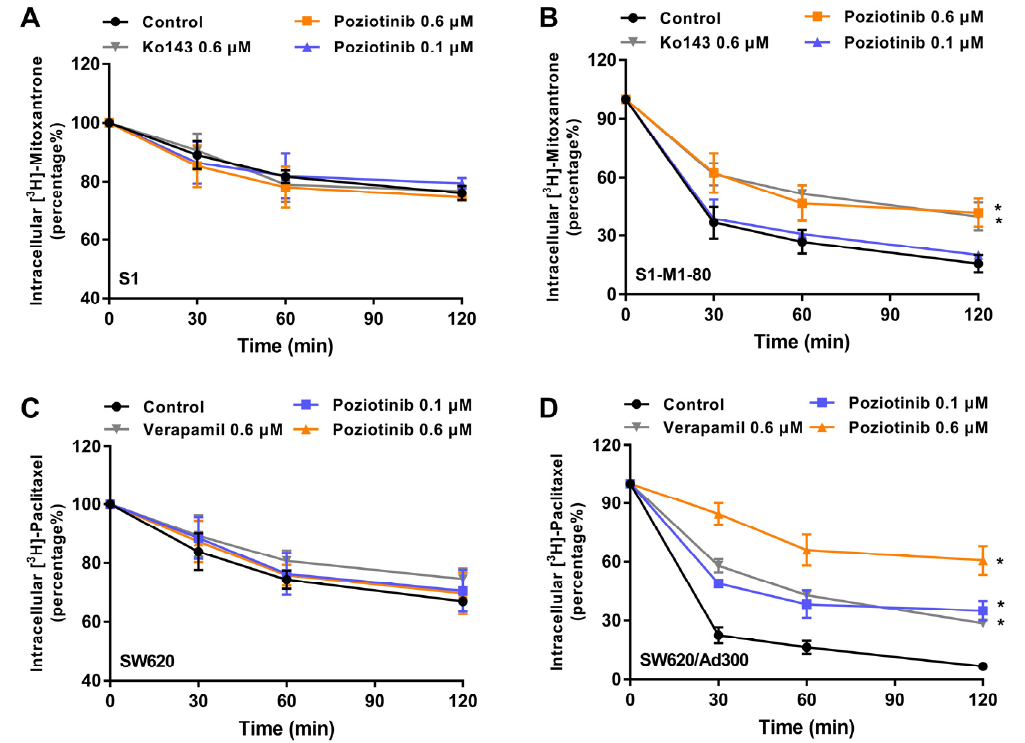
Figure 7. Poziotinib inhibits the efflux of the ABCG2 and ABCB1 substrates, [ 3 H]-mitoxantrone and